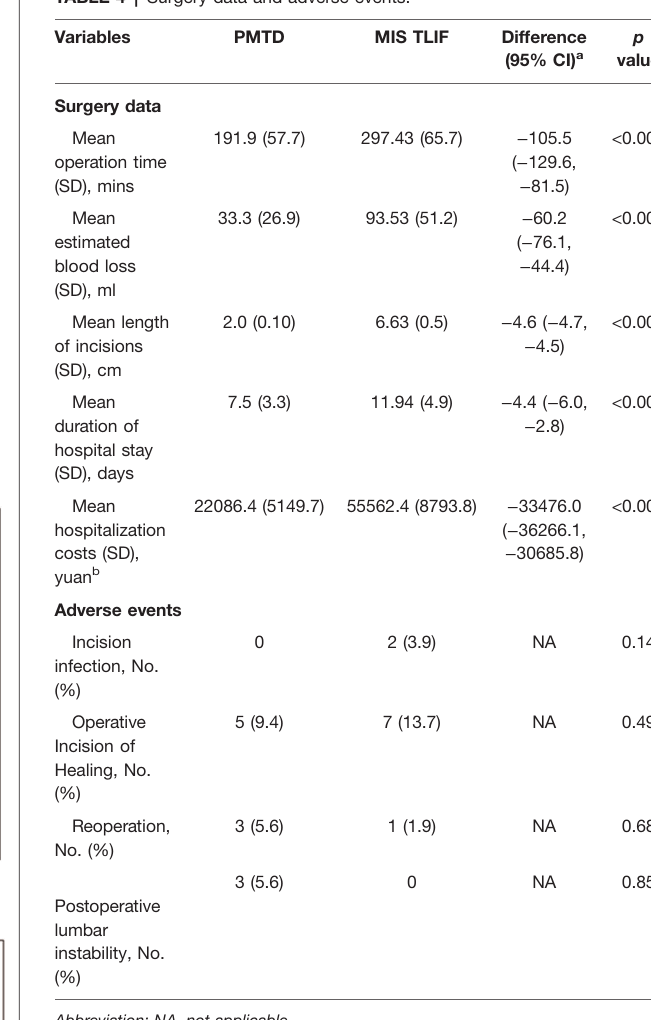
TABLE 4 | Surgery data and adverse events.